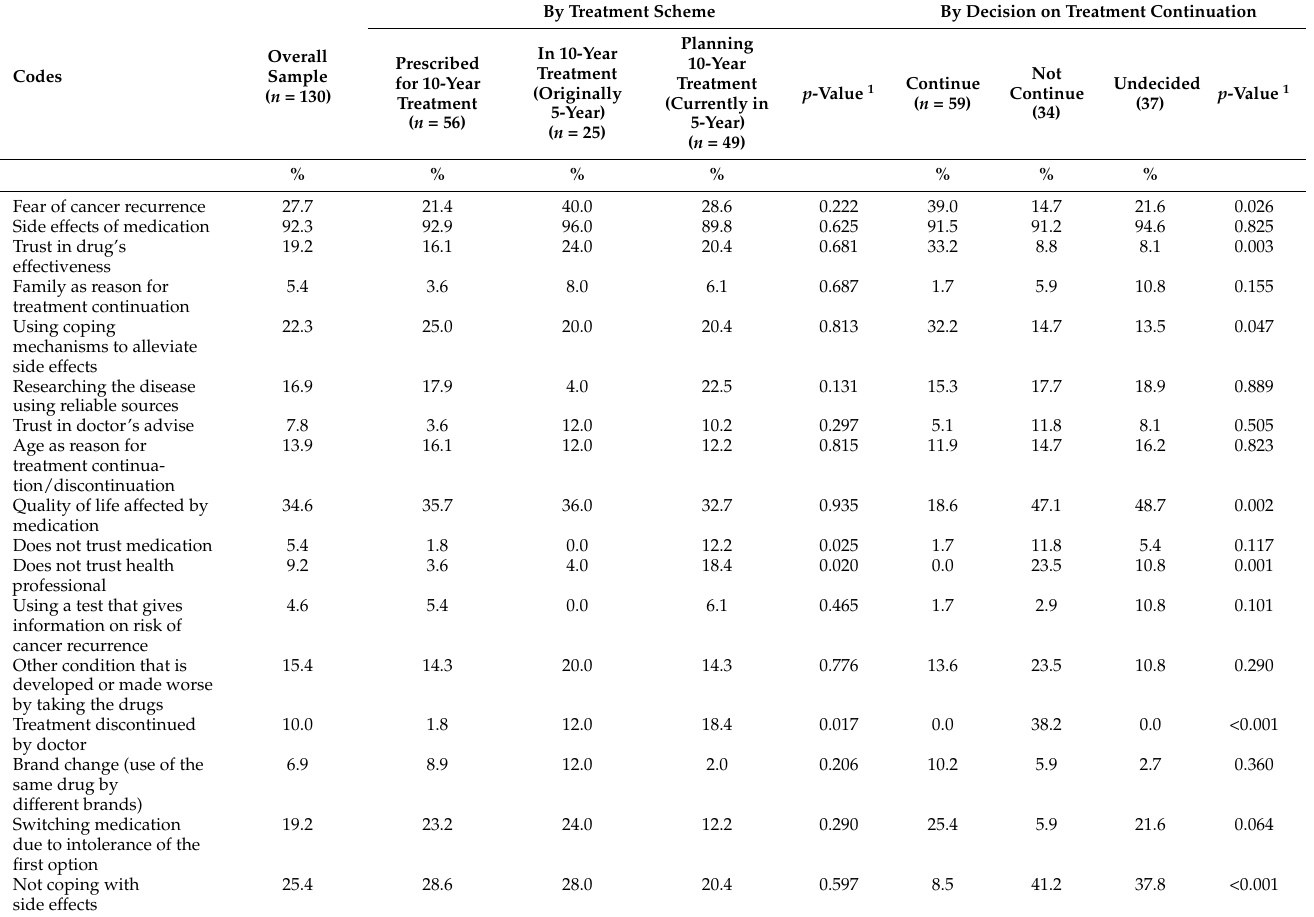
Table 2. Proportion of participants (%) who mentioned various codes, overall and by specific categories.